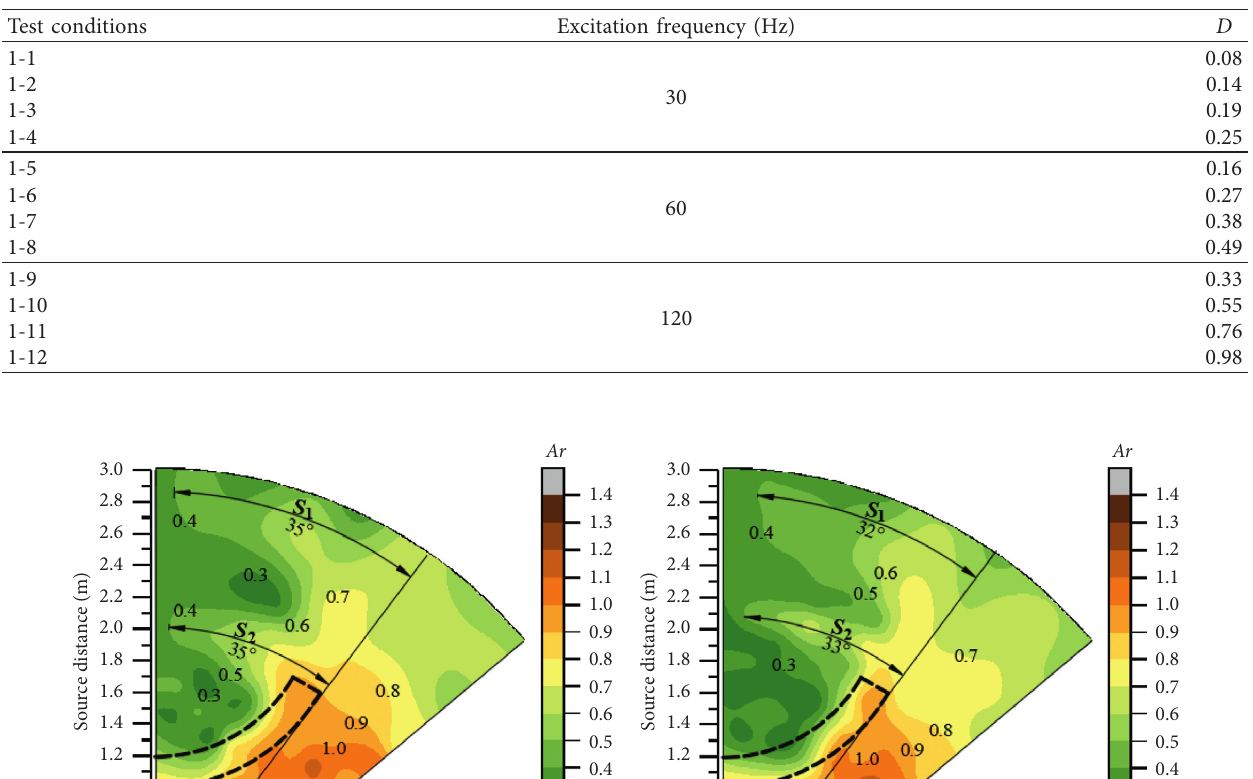
Table 4: Test arrangement of the parameter d